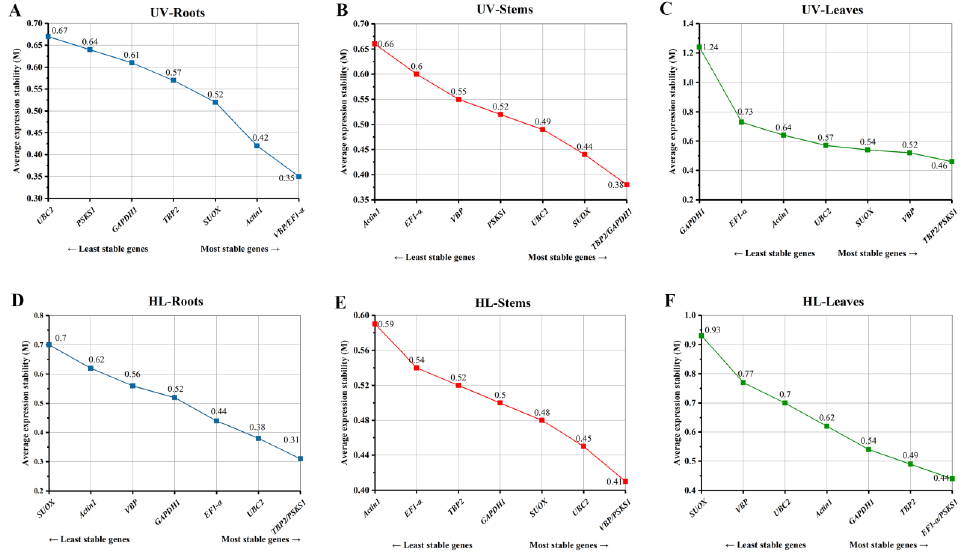
Figure 2. Expression stability of eight reference genes in different oat tissues under UV-B ( A – C ) and high-light ( D – F ) stresses based on geNorm analysis. In geNorm analysis, the pairwise variant analysis provides criteria for selecting the optimal combination of the number of candidate reference genes, and if the V n /V n + 1 is less than 0.15, the best solution is the top n reference genes ranked together as the refer- ence genes. As shown in Figure 3, V 3 /V 4 was less than 0.15 in the leaves under UV-B and high-light stresses, indicating that three reference genes should be used for the normali- zation of target gene expression data. V 2 /V 3 was less than 0.15 in the roots and stems under UV-B and high-light stresses, indicating that two candidate reference genes are needed for normalizing gene expression data. Figure 3. geNorm analysis of the pairwise variation (V) values for eight candidate reference genes under UV-B ( A ) and high-light ( B ) stresses.